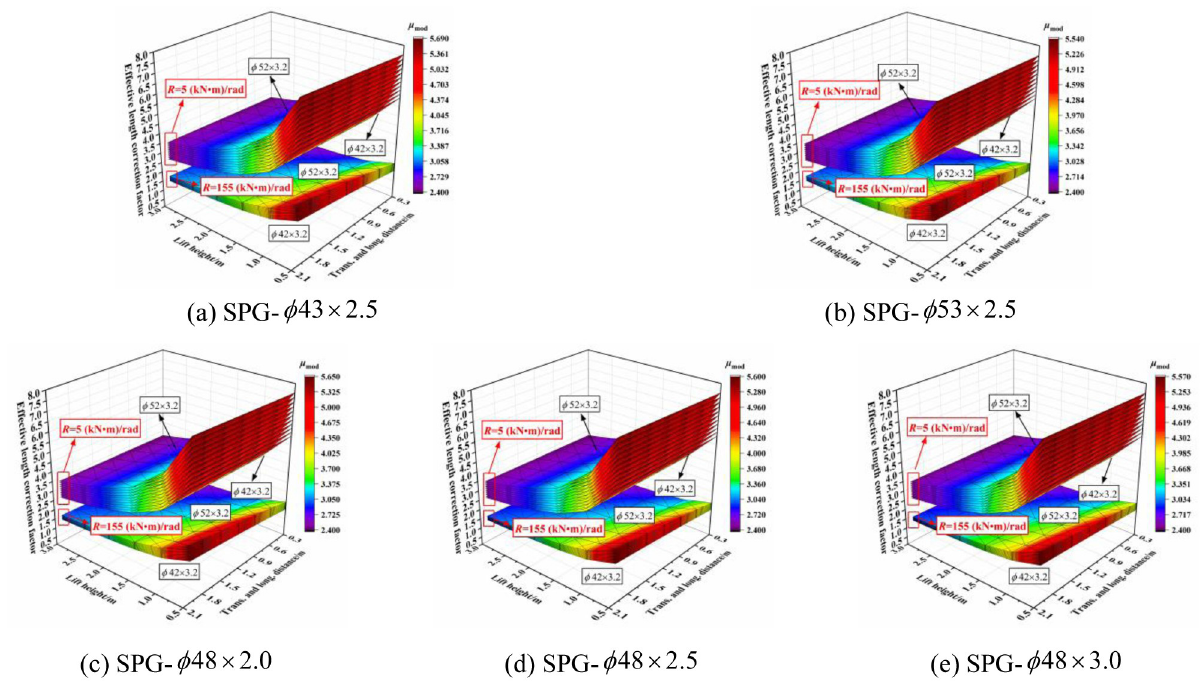
Fig 24. Three-dimensional diagrams of the influence of outer diameter size of vertical pole section on the effective length correction factor. (a) SPG- ϕ 43 × 2.5. (b) SPG- ϕ 53 × 2.5. (c) SPG- ϕ 48 × 2.0. (d) SPG- ϕ 48 × 2.5. (e) SPG- ϕ 48 × 3.0.